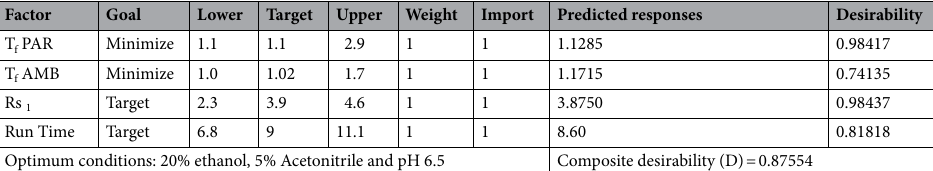
Table 1. Response optimization of 2 3 full factorial design for HPLC–UV separation of quaternary mixture.